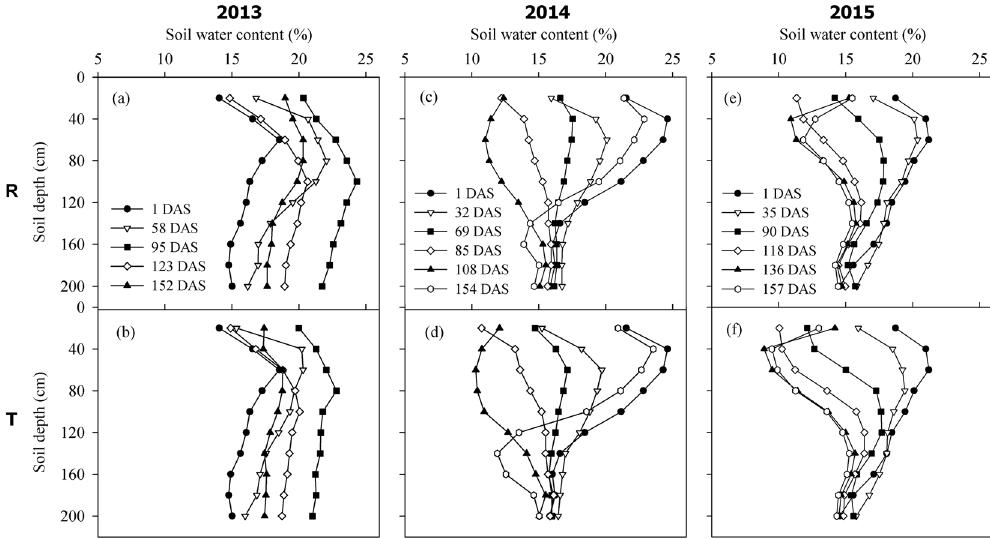
Figure 1. Dynamic variations in the soil water content (%) profile in the 0–200 cm soil layers with days after sowing (DAS) under two planting patterns regardless of the fertilizer rate in the 2013–2015 growing seasons for foxtail millet. Note: R = ridge and furrow rainfall harvesting planting; T = traditional flat